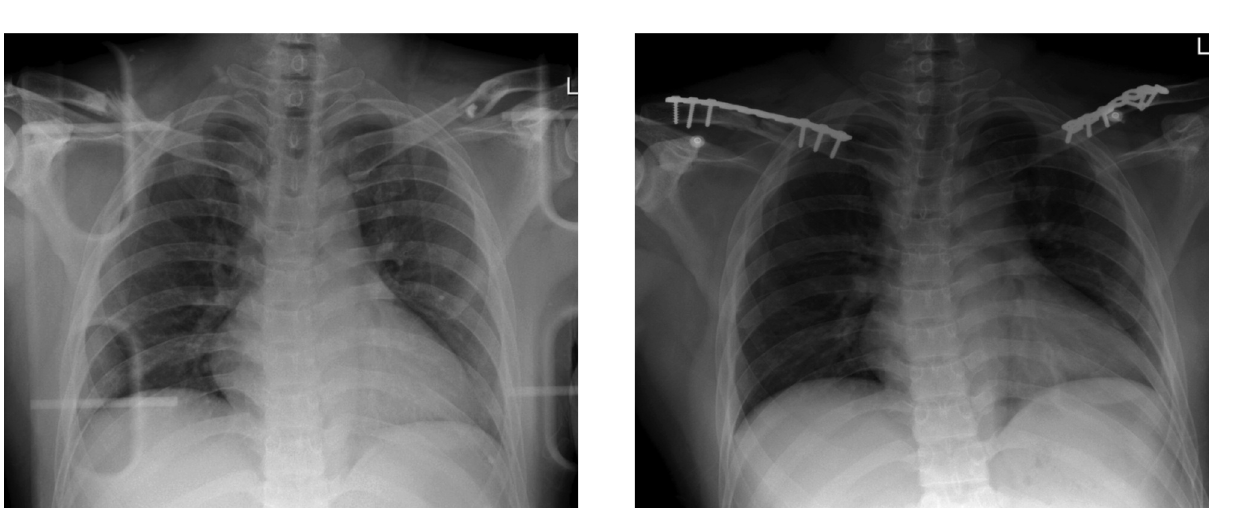
Bilateral clavicles fracture with no other injury seen. Fig. 1a: The radiograph was taken during patient was stabilized with arm board.